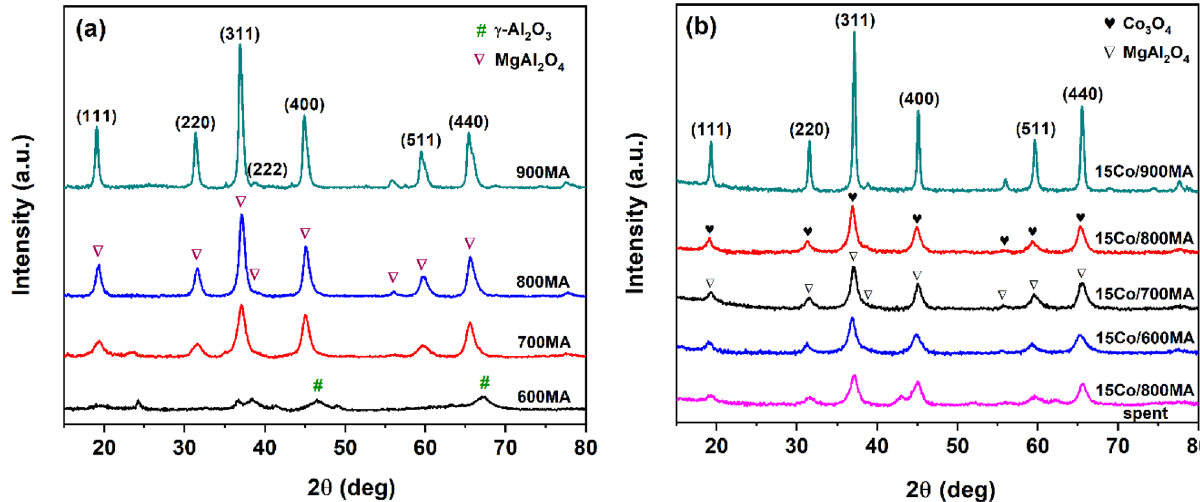
Figure 1. XRD patterns of ( a ) MgAl 2 O 4 spinel at various activation temperatures and ( b ) cobalt supported